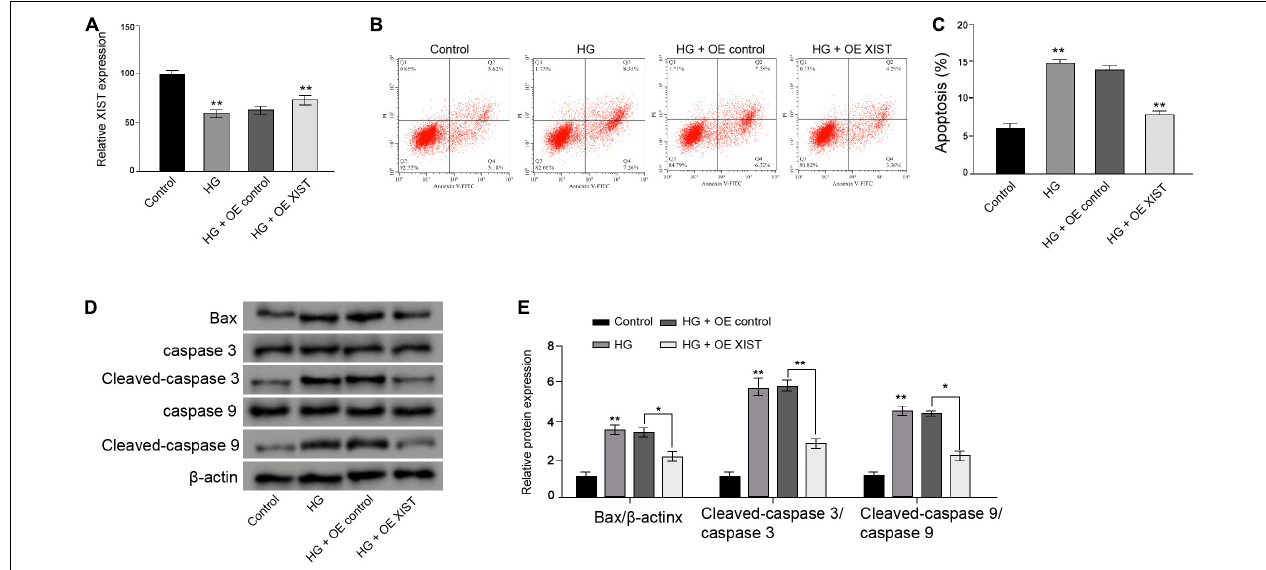
FIGURE 2 | XIST attenuates high glucose-induced apoptosis in the Schwann cells. (A–D) The RSC96 cells are treated with HG, or co-treated with HG and pcDNA-3.1-XIST overexpression vectors. (A) The expression of XIST is measured by qPCR assays. (B,C) The apoptosis is detected by flow cytometry analysis. (D,E) The expression of Bax, caspase3, cleaved-caspase3, caspase9, and cleaved-caspase9 is assessed by Western blot analysis. N = 3, mean ± SD, * P < 0.05, ** P < 0.01.